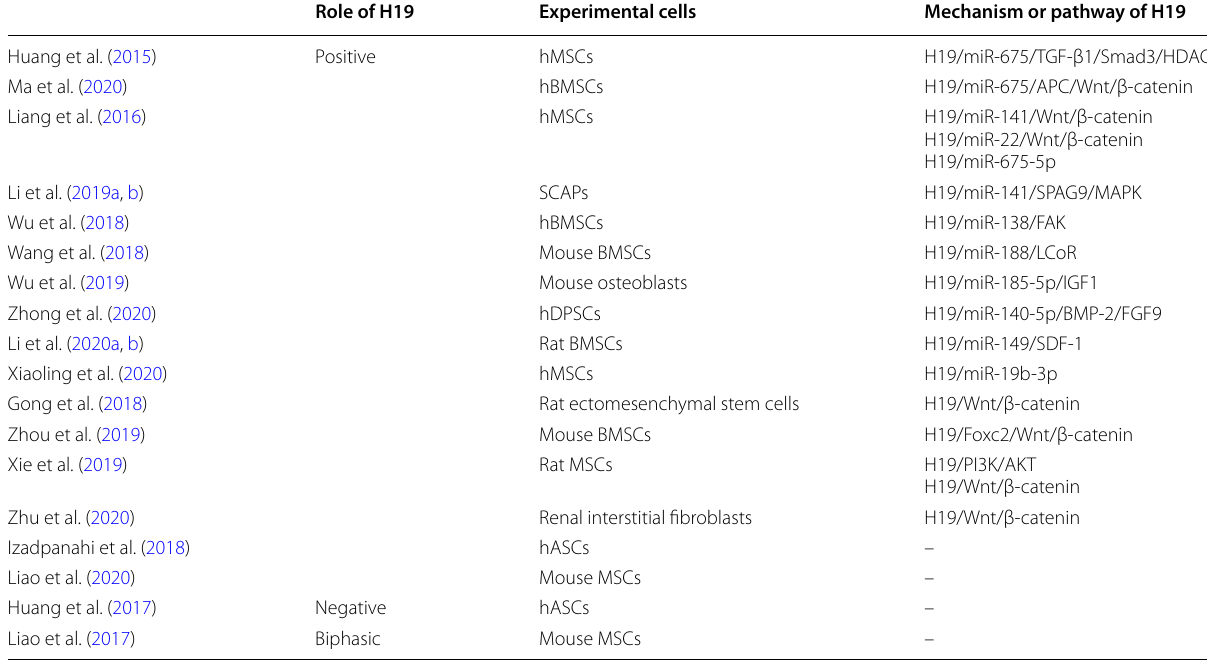
hMSCs human mesenchymal stem cells, BMSCs bone marrow mesenchymal stem cells, hASCs human adipose-derived stem cells, SCAPs stem cells from apical papilla, hDPSCs human dental pulp stem